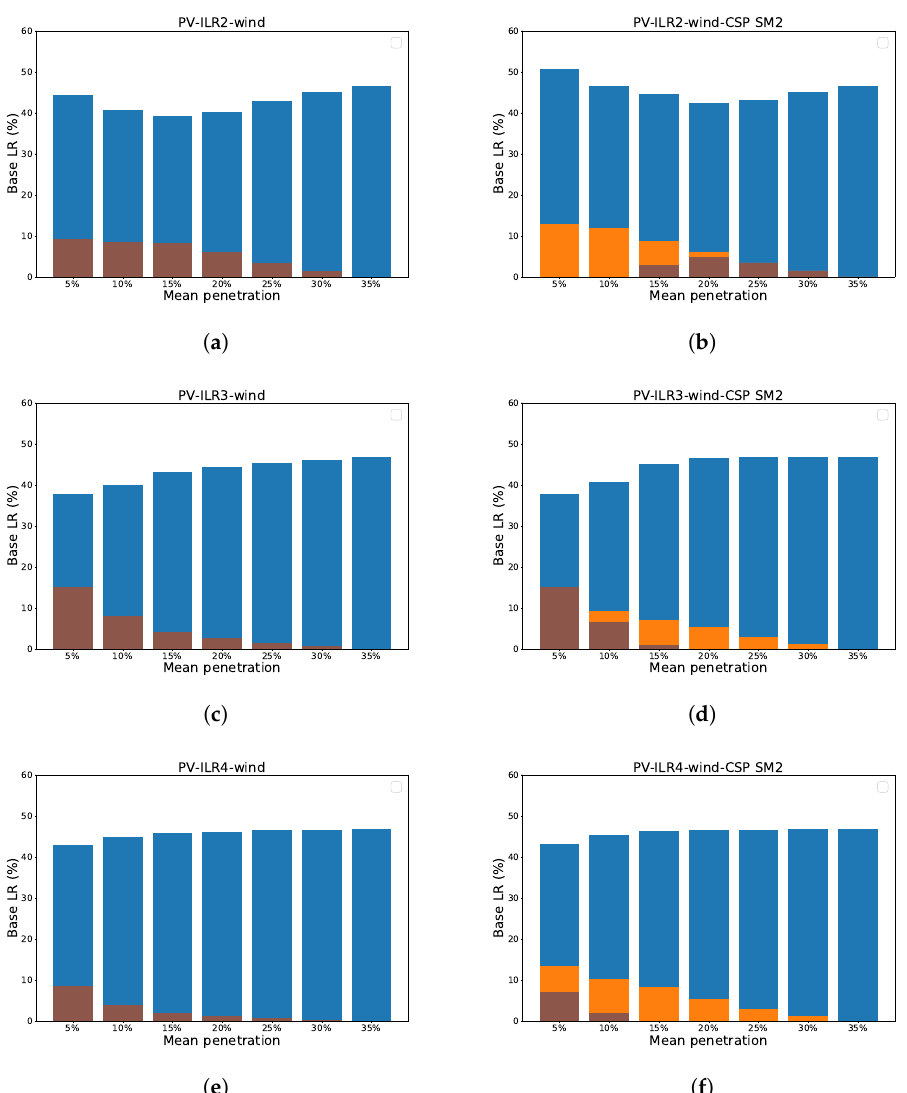
Figure 11. Base load reduction by each technology—Wind (blue), PV-BES (brown) and CSP-TES (orange)—versus the mean penetration (1), µ , for the global strategy (2) with maximum-cost con- straint (5). ( Left ) PV-BES-wind mix; ( Right ) PV-BES-wind-CSP-TES SM2 mix. ( Top ) ILR2; ( Middle ) ILR3; ( Bottom )